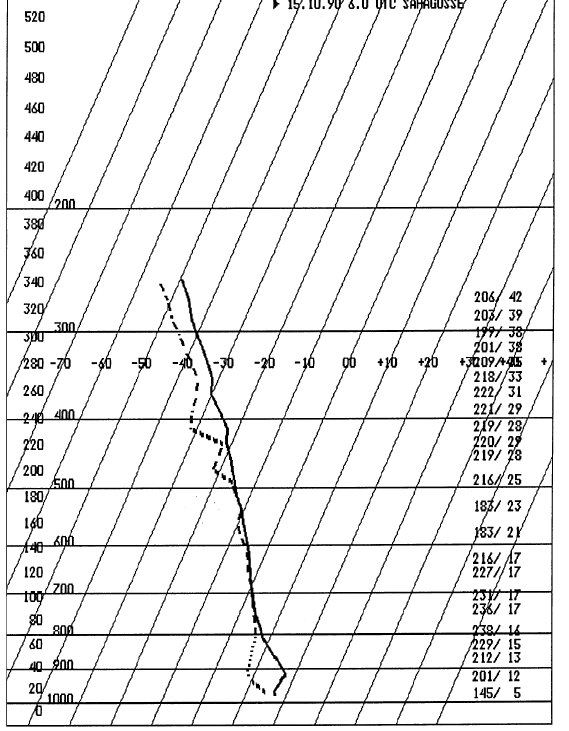
Fig. 7. Upstream profiles from radiosonde soundings: 15 October, 06:00 UT at Zaragoza. Temperature ( solid line ) and dewpoint temperature ( dashed line ). The arrows show the height of the tropopause. The values on the right side of each graph represent the direction (in degrees) and the wind-speed (in m s (cid:255) 1 ) respectively. The values on the left border represent the altitude in hundreds of